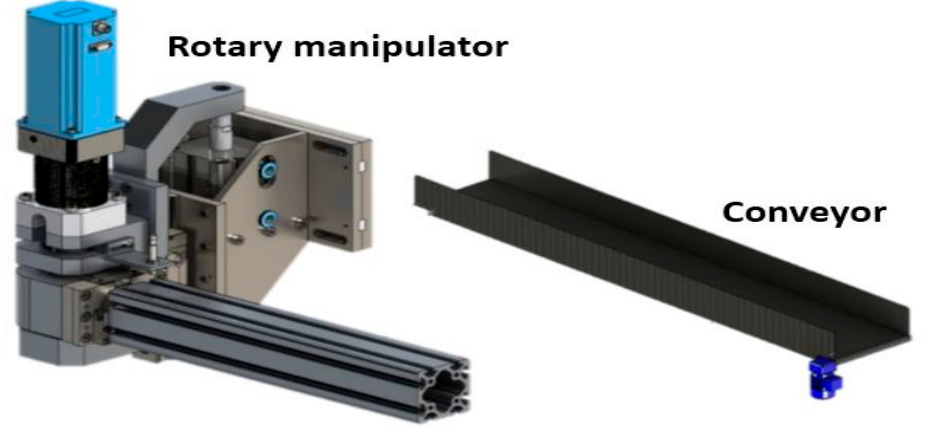
Figure 8. Rotary manipulator and conveyor. mold. The relative position of the wires among them needs to remain the same as